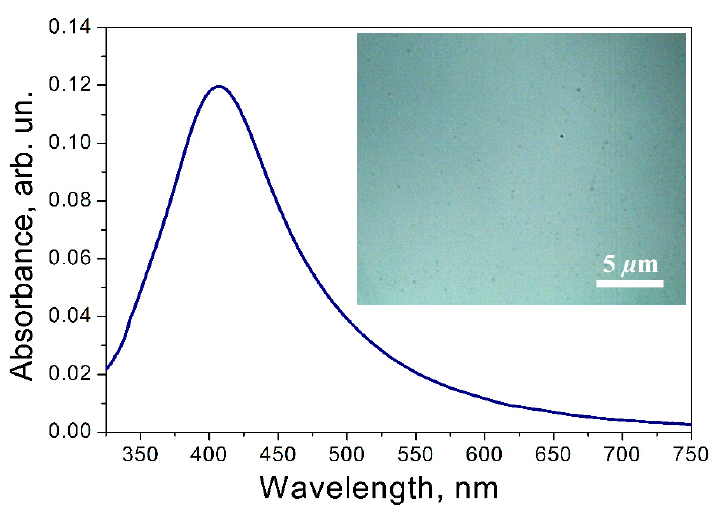
Figure 7. Extinction spectrum from the Ag NPs of sample II irradiated by a dose of 4.5 × 10 16 . The insert is an optical image.